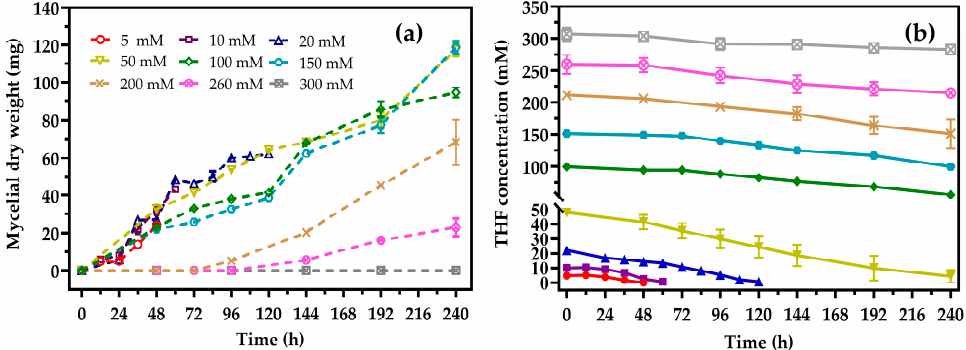
Figure 2. Growth ( a ) and THF degradation ( b ) of strain ZM01 with different initial THF concentrations at 30 °C: All values represent the mean of three independent biological replicates.